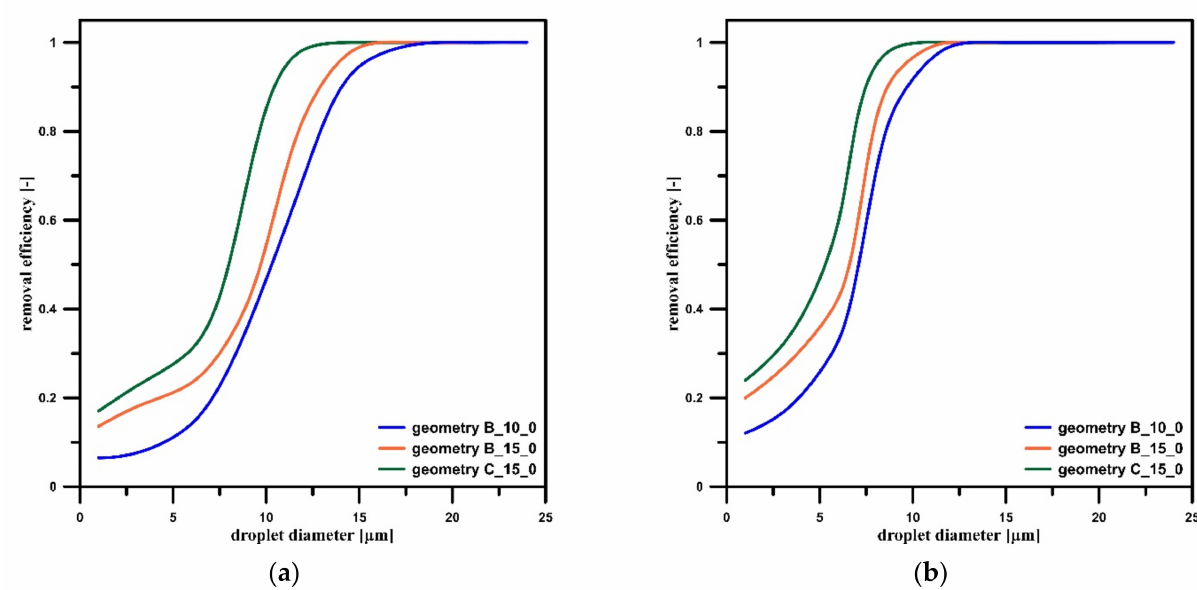
Figure 18. Comparison of calculated results of droplet removal efficiency for geometries B_10_0, B_15_0, and C_15_0 with inlet velocity: ( a ) 2 m s − 1 ; ( b ) 4 m s − 1